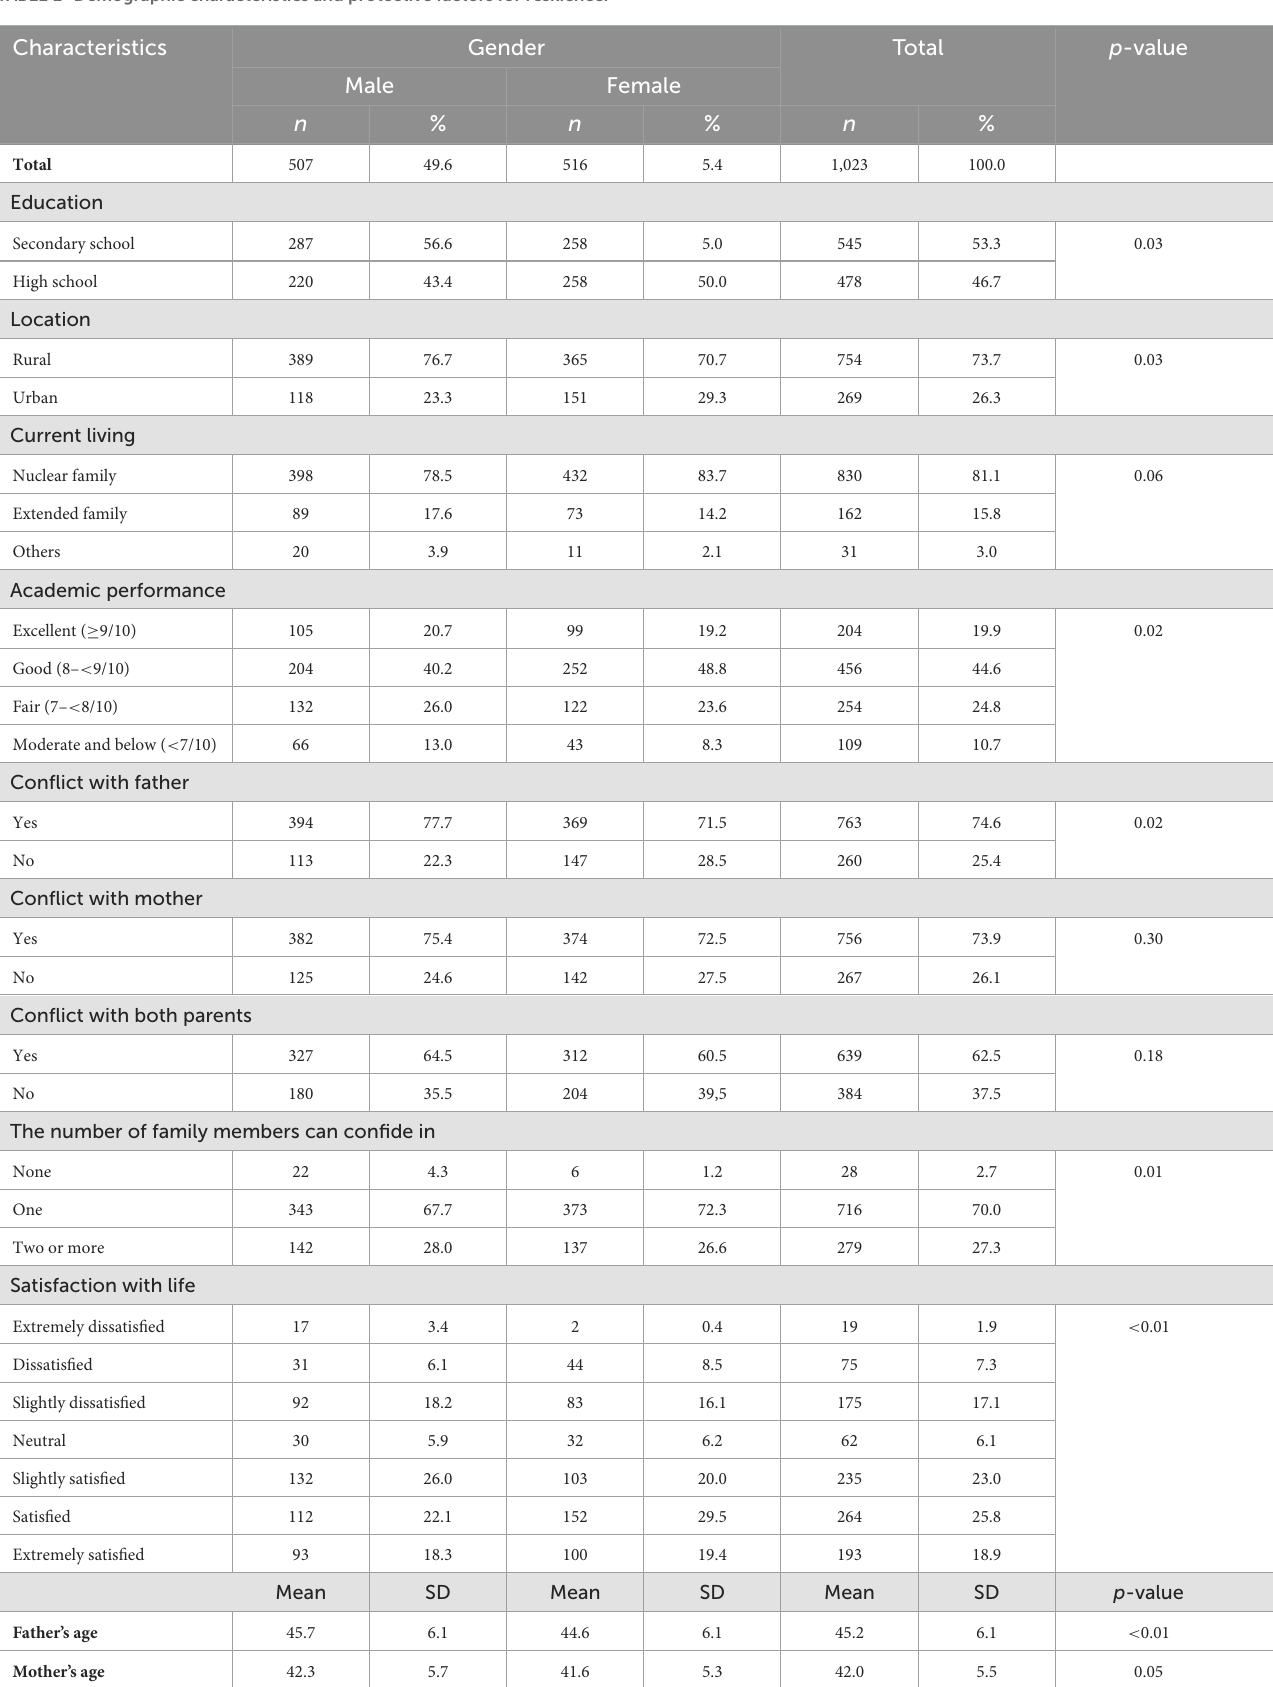
TABLE 1 Demographic characteristics and protective factors for